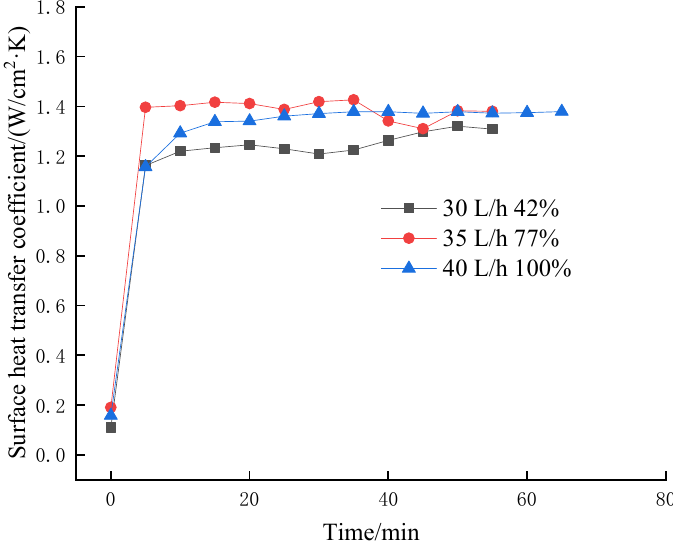
Figure 7. Visualization images of the influence of flow rate change on spray coverage at a heating heat flux of 100 W/cm 2 : ( a ) flow rate 25 L/h; ( b ) flow rate 30 L/h, coverage 42%; ( c ) flow rate 35 L/h, coverage 77%; ( d ) flow rate 45 L/h, coverage 100%.